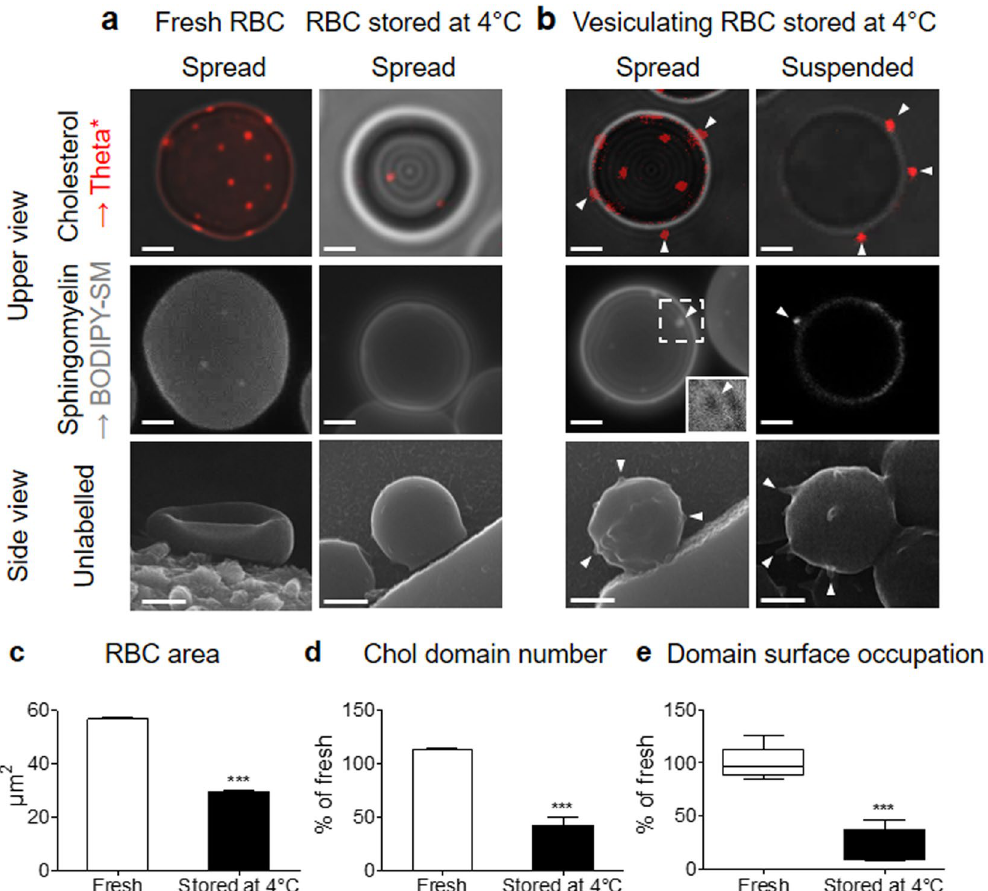
Figure 9. Specific vesiculation of chol- and SM-enriched domains upon storage at 4 °C. Fresh and stored (15 days at 4 °C) healthy RBCs were labelled ( a and b , upper and central panels ) or not ( a and b , lower panels ), left in suspension (suspended) or spread ( spread ) and observed by vital confocal/fluorescence microscopy ( a and b , upper and central panels ) or SEM ( a and b , lower panels ). ( a , b ) Representative imaging. White arrowheads point to membrane vesiculation ( b ). SM-enriched vesiculating domain in spread RBC is boxed and can be observed by specific transmission pattern (see 2x zoom in right lower corner of the image). Representative images of 2–3 independent experiments, scale bars 2 µ m. ( c – e ) Quantification of RBC area (c; µ m 2 by hemi-RBC), chol-enriched domain number (d; average by hemi-RBC expressed as percentage of fresh RBCs) and domain surface occupation (e; total domain area by hemi-RBC area, expressed as percentage of fresh RBCs). Results are means ± SEM of 128–252 RBCs from two independent experiments. Statistical significance was tested with two-sample